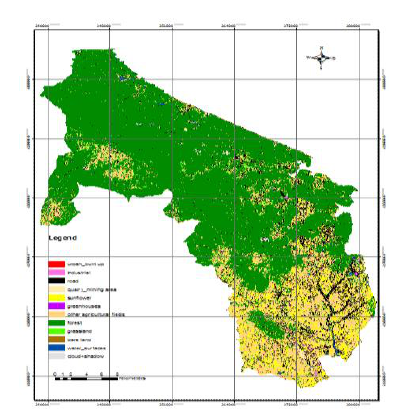
Figure 3. Classification results for: (a) MLC, and (b) SVM The output of the classified images without any error or bias is the accurate thematic map. There are a number of equations that can show the level of error statistically, such as producer accuracy, user accuracy, overall accuracy, and Kappa, which can be calculated using the error matrix (Foody, 2002). using collected ground-truth data for all two types of classification using a standard error matrix. Kappa statistics and overall accuracy were used to compared to determine the performance of the selected methods for the selected heterogeneous region (Table 2).